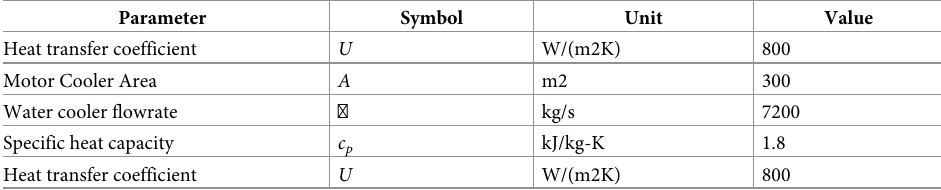
Table 3. Parameter assumption for motor cooler